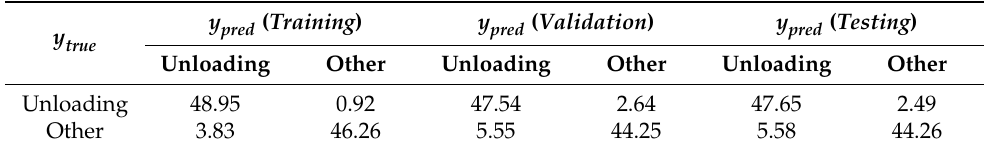
Table 4. Confusion matrix created for haul trucks network model.